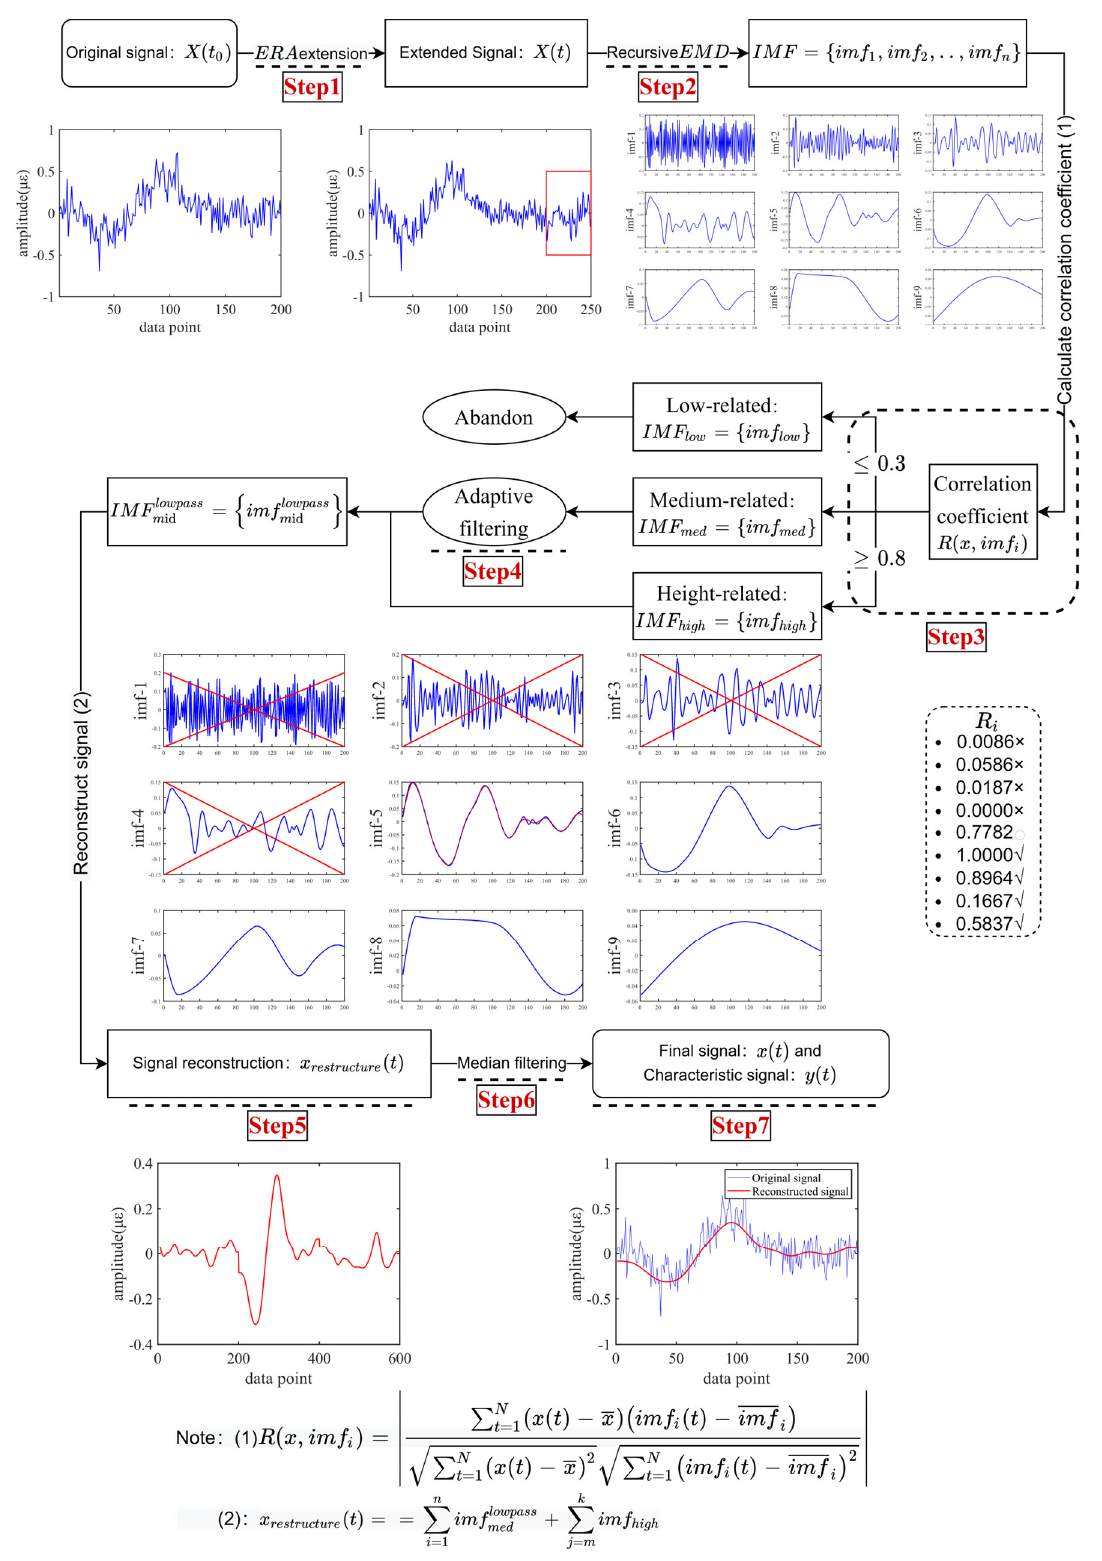
Figure 5. OREMD diagram. The blue line indicates the original signal, the red line indicates the valid signal after sifting.